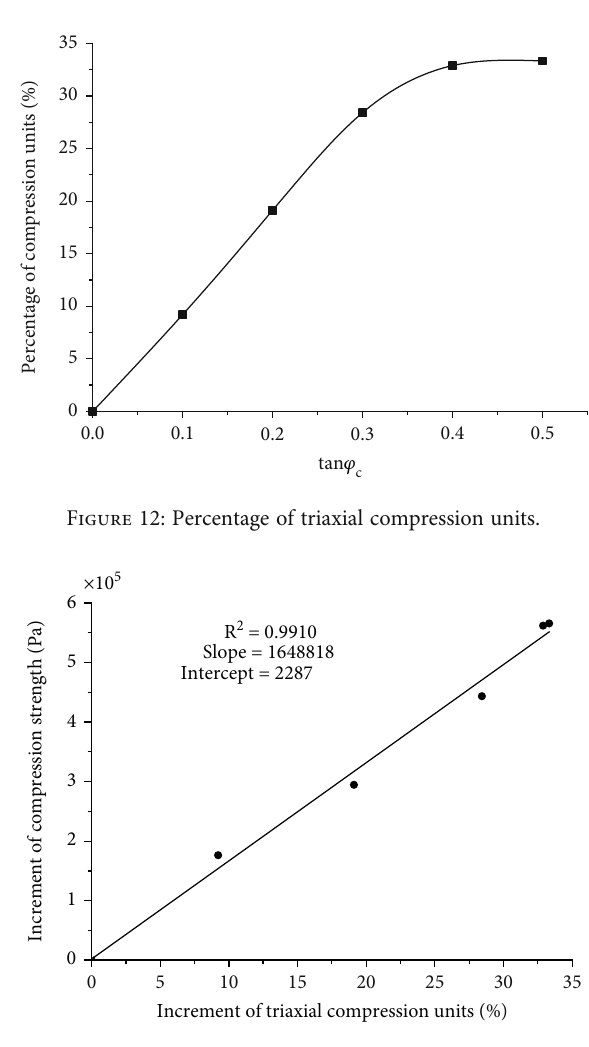
Figure 13: Increment between triaxial compression unit and compression strength.